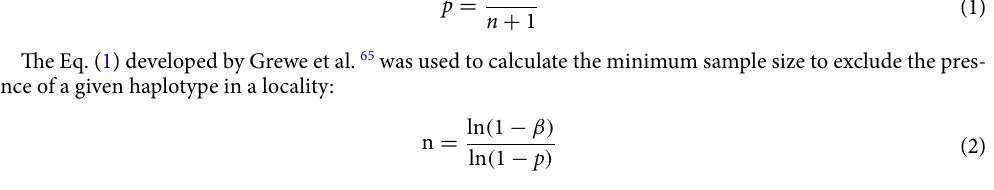
Supplementary Table S1 . COI sequences were aligned using the ClustalW algorithm included in BioEdit 54 , ITS2-28S sequences (here- after nuclear regions) were aligned as a whole using the G-INS-I algorithm in MAFFT 7 55 and this alignment was used for concatenated analysis. Ribosomal regions were also used separately in single-gene phylogenetic analyses. To perform phylogenetic reconstructions, all the homologous sequences of Carpophilus available in GenBank and BOLD were included in the analyses (www. ncbi. nlm. nih. gov/ genba nk/; www. bolds ystems. org; last accessed on 21 November 2021) setting a threshold of 70% similarity with the sequences obtained. Not all markers were available on GenBank (or BOLD for COI) databases for each species, hence different genes or their portions were analyzed both separately and combined to get a clearer picture of phylogenetic rela- tionships. Phylogenetic reconstructions were performed by conducting a maximum likelihood (ML) analysis in RAxML version 8.2.10 56 using the RAXMLGUI v. 2.0.5 57 for every marker (COI, ribosomal regions and combined molecular markers, and Bayesian inference (BI) in MrBayes 3.2 58 for the COI barcode portion and combined molecular markers. For the ML and BI analyses, the GRT + G + I evolutionary model selected by jModeltest 59 was used for each genetic portion except ITS2, for which GRT + G model fit better. The phylogenetic reconstruction based on a concatenated dataset (COI + ribosomal regions) included all the Carpophilus species for which we obtained sequences of all markers for at least one specimen, and those available on public databases that were related to our samples based on single-gene phylogenetic analyses. Partitioned evolutionary models, according to the best partitioning scheme found by Partition Finder 60 , were used for the BI analysis on concatenated dataset. Trees were rooted by setting Aethina tumida (Coleoptera: Nitidulidae, Nitidulinae) as outgroup for COI and 28S or using the midpoint-rooted tree option for markers where outgroups were not available (acc. num.: KP134137 and KP134071). Phylogenetic trees were drawn by using FigTree software v1.4.2 61 . COI genetic distances